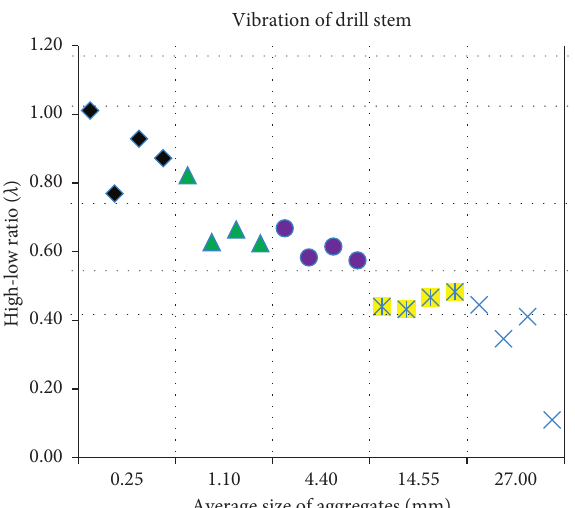
Figure 11: High-low ratio of vibration frequency of drill stem vs. aggregate size.